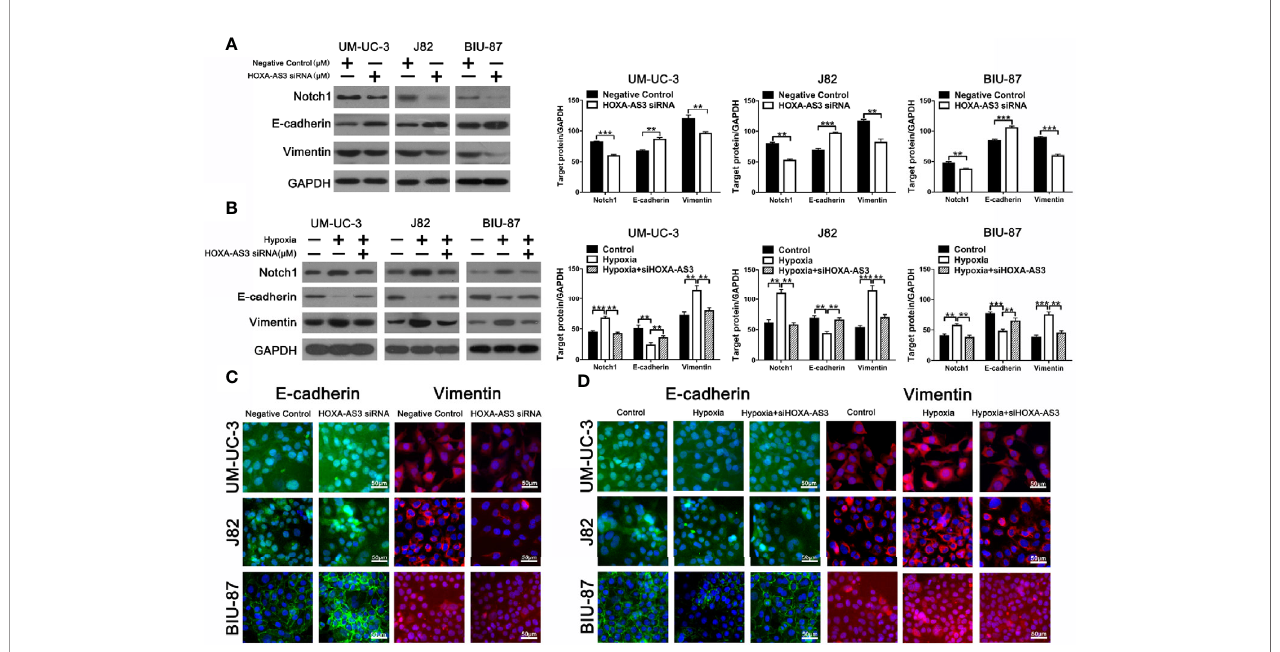
FIGURE 3 | HOXA-AS3 regulates Notch1 expression and reverses hypoxia-induced EMT in bladder cancer (BC) cells. (A , B) Protein levels of EMT markers and Notch1 in bladder cancer cells transfected with a negative control or HOXA-AS3 small interfering RNA (siRNA) under normoxic or hypoxic conditions, by western blot analysis. **P < 0.01, ***P < 0.001. (C , D) Immuno fl uorescence analysis of E-cadherin and vimentin expression in BC cells transfected with a negative control or HOXA-AS3 siRNA under normoxic or hypoxic